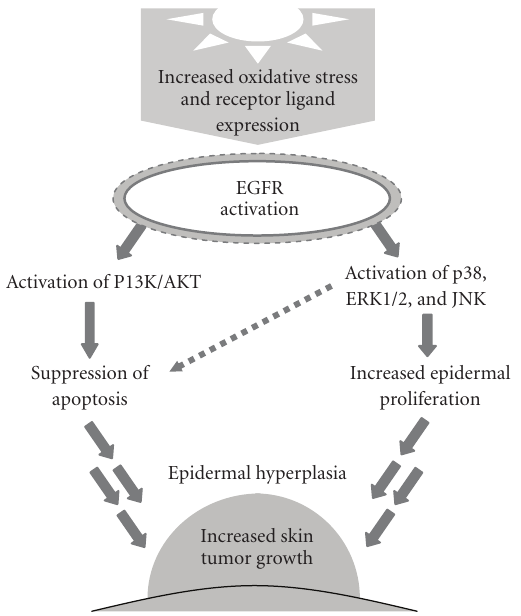
Figure 1: Mechanisms through which the UV-induced activation of EGFR contributes to skin